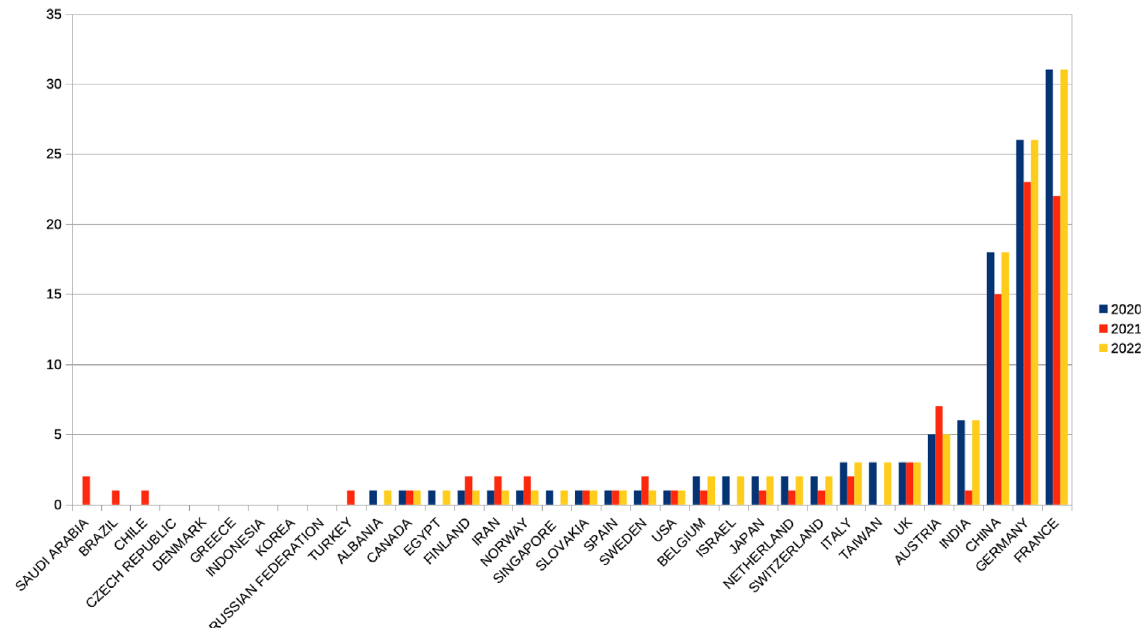
Figure 5. Submissions according to